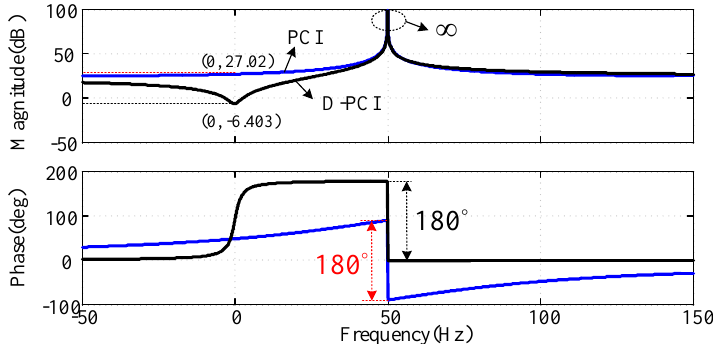
Figure 6. Bode plot of PCI and D-PCI controllers tuned at ω e = 2 · π · 50 rad/s.